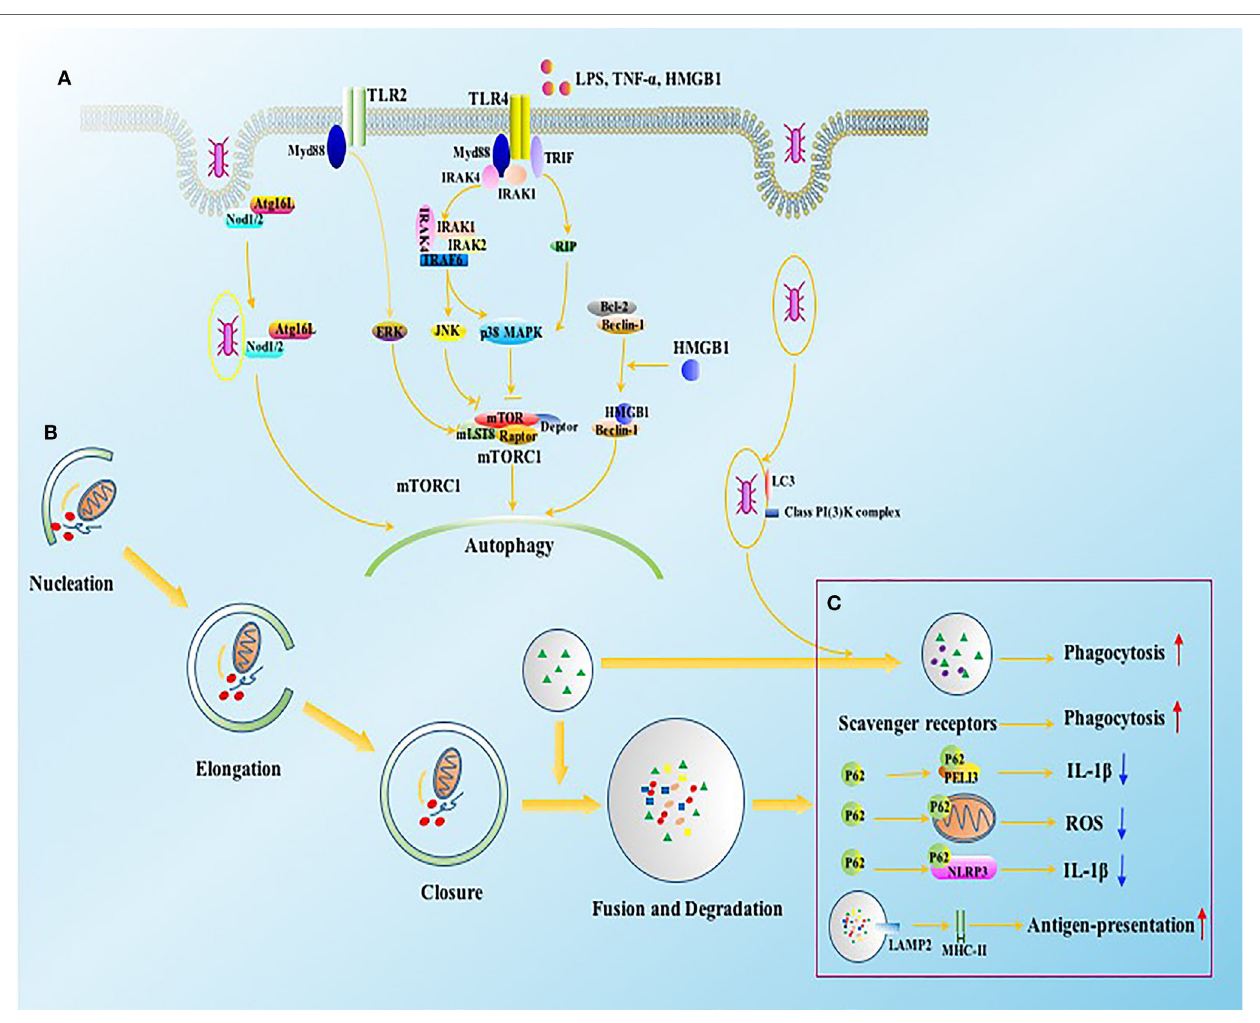
FiGURe 2 | The intracellular signals of autophagy induction in immune cells. (A) Autophagy can be induced by bacteria, bacterial toxins such as LPS, and pro­inflammatory cytokines through TLR2 and TLR4. The activation of TLR4 and TLR2 initiate JNK, p38 MAPK, and ERK signaling in Myd88 and TRIF dependent ways, which further induce autophagy by inhibiting mTORC1 complex. NOD1 and NOD2 receptors, vital intracellular pattern recognition receptors, promote the formation of autophagosomes by enhancing the combination between ATG16L1 and invaded bacteria. HMGB1 induces autophagy through releasing Beclin­1 from Bcl2 after binding with Beclin­1. (B) Four major steps are required for autophagic process, including nucleation, elongation, closure, and fusion with lysosome for degradation, which are tightly regulated by autophagy associated proteins. (C) The function of autophagy associated proteins on immune system involves both canonical and non­canonical dependent ways. ATG16L1, autophagy­related 16­like 1 gene; Bcl2, B­cell lymphoma 2; ERK, extracellular signal­regulated kinase; HMGB1, high­mobility group box­1 protein; IL, interleukin; IRAK, interleukin­1 receptor­associated kinase; JNK, c­Jun N­terminal kinase; LAMP, lysosomal­ associated membrane protein; LPS, lipopolysaccharide; MHC, major histocompatibility complex; mLST8, mammalian lethal with SEC13 protein; mTOR, mammalian target of rapamycin; mTORC1, mTOR complex 1; Myd88, myeloid differentiation factor 88; NOD, nucleotide­binding oligomerization domain­containing protein; PELI3, pellino E3 ubiquitin protein ligase family member 3; p38 MAPK, p38 mitogen­activated protein kinase; RIP, receptor interacting protein; ROS, reactive oxygen species; TNF, tumor necrosis factor; TRAF, TNF receptor­associated factor; TRIF, TIR­domain­containing adapter­inducing interferon­ β